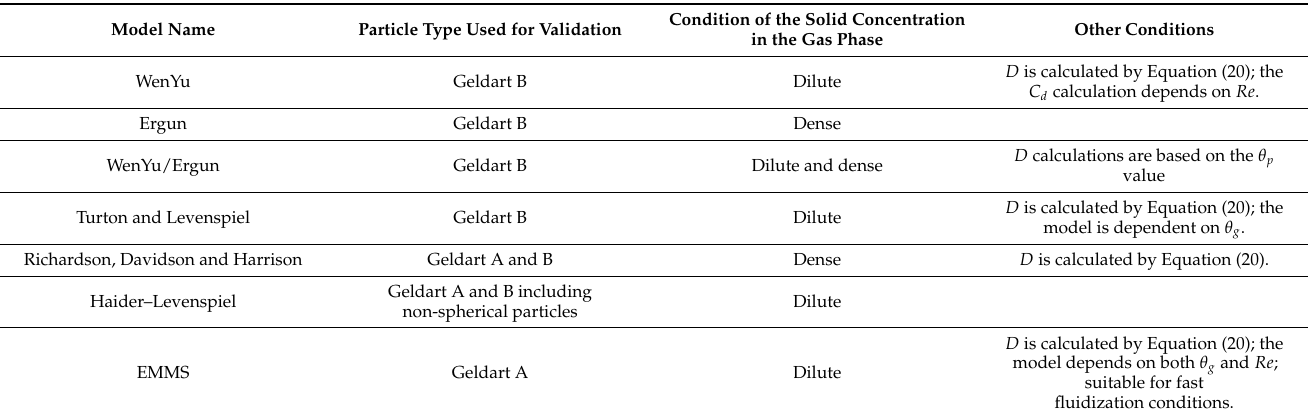
Table 3. Information about the drag models available in Barracuda ®